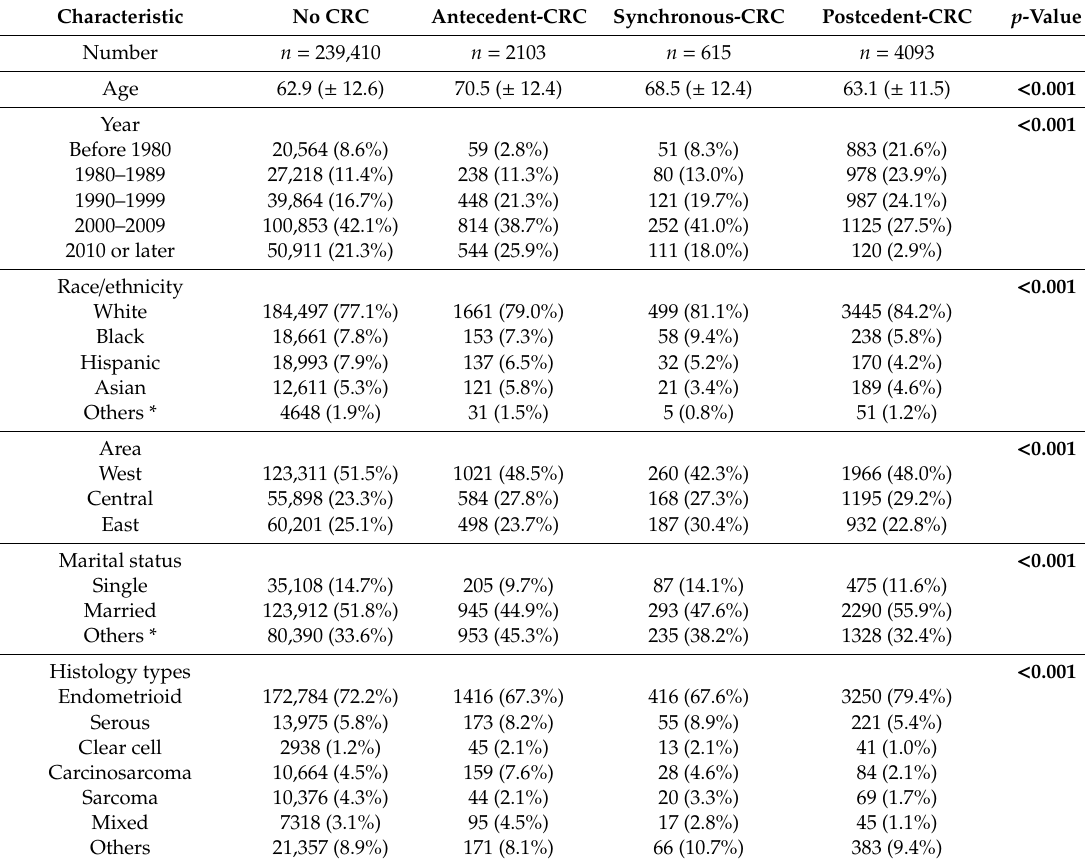
Table 1. Patient demographics for uterine cancer based on timing of secondary colorectal